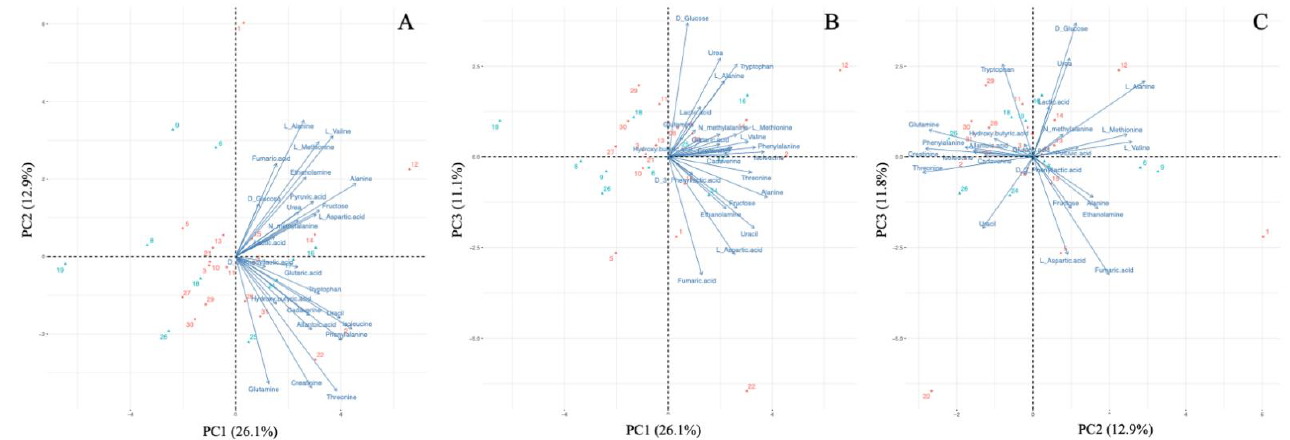
Figure 1. Principal component analysis of metabolites. ( A ) First principal component (PC1) versus second principal component (PC2). ( B ) PC1 versus third principal component (PC3). ( C ) PC2 versus PC3. Red dots indicate animals from the polluted site (Mutwe Wansofu), and blue dots indicate animals from the control site (Kang’omba).